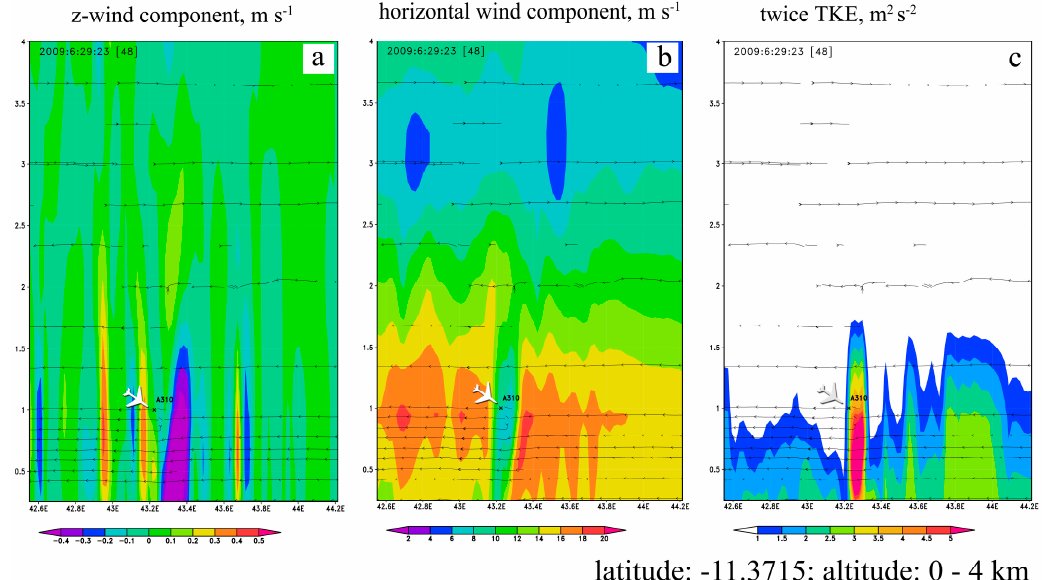
Figure 11. The Airbus A310-324 crash site, Comoros Islands, 2009. The vertical cross-section in the 0–4 km layer of the z-wind speed ( a ), the magnitude of horizontal wind speed ( b ) and QKE ( c ). The A310-324 crash site is indicated by a marker.